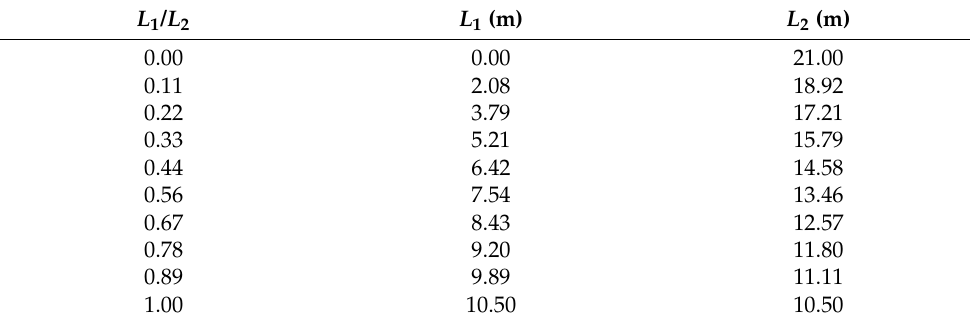
Table 3. Values considered for the investigated ratios of L 1 / L 2 .